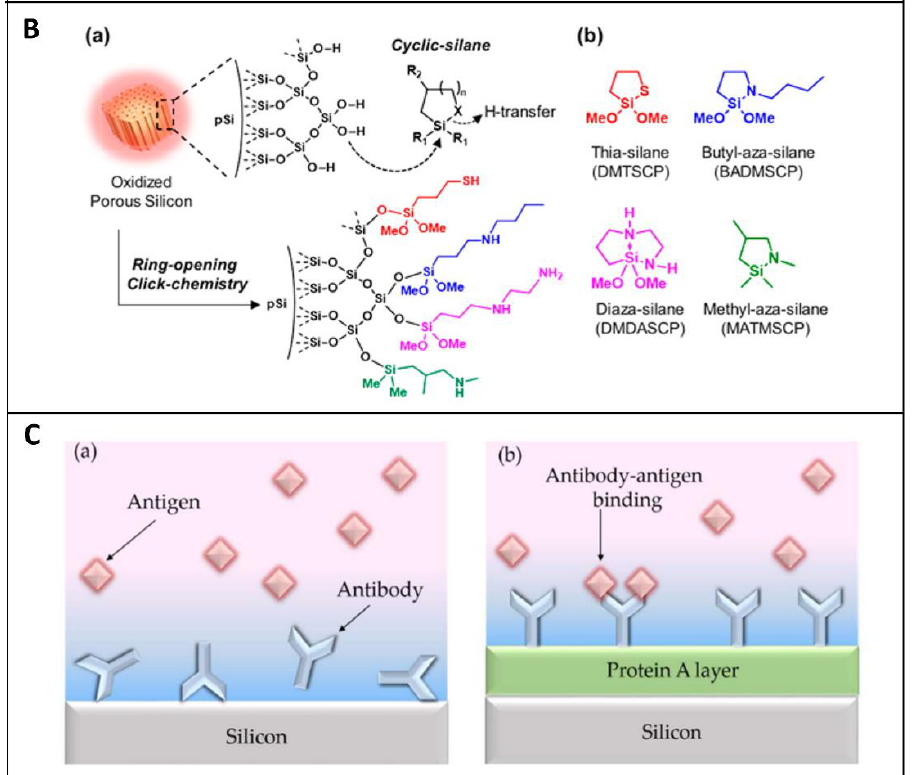
Figure 2. ( A ) Scheme of PSi functionalization through thermal oxidation and silanization with APTES or APDMES. Reprinted with permission from Reference [60]. ( B ) (a) Scheme of oxidized porous silicon modified through a ring-opening click reaction; (b) structure of reagents used for the study—thia-silane (DMTSCP, 2,2-dimethoxy-1-thia-2-silacyclopentane), butyl-aza-silane (BADMSCP, N - n -butyl-aza-2,2-dimethoxy-silacyclopentane), diaza-silane (DMDASCP, 2,2-dimethoxy-1, 6-diaza-2-silacyclooctane), and methyl-aza-silane (MATMSCP, N -methyl-aza-2,2,4-trimethyl-silacyclopentane). R 1 = OMe, Me. R 2 = H, Me. Reprinted with permission from Reference [65] https://pubs.acs.org/doi/10.1021/jacs.6b08614 (accessed on 16 December 2020). Copyright (2016) American Chemical Society. ( C ) (a) Cartoons of randomly immo- bilized antibodies via physical adsorption and (b) properly orientated on the PSi matrix by using an